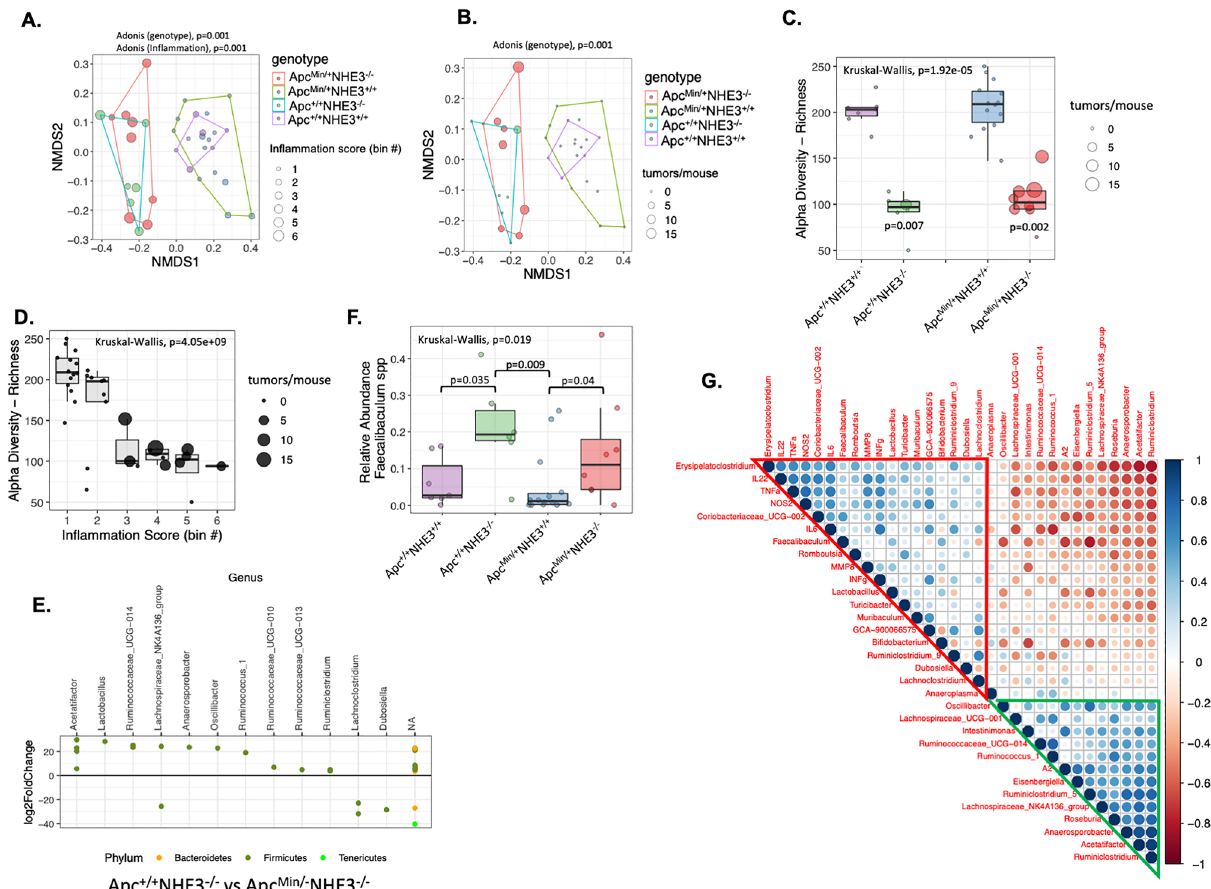
Figure 4. NHE3 deficiency leads to microbial dysbiosis and correlates with severity of inflammation and tumor number. Non-metric Multidimensional Scaling (NMDS) analysis based on Bray–Curtis distances ( A , B ), and richness (a-diversity measure; C , D ) were used to analyze the groups in the context of genotype, inflammation score, and tumor number. In all panels, dots represent samples from individual mice. The size of the dots corresponds to the inflammation score ( A ) or to the tumor multiplicity ( B – D ). Polygons connect points within the same cluster representing individual genotypes ( A , B ). In the bar plots ( C , D ) the lower and upper hinges represent the first and third quartiles respectively. The whiskers extend to the largest and lowest values. The middle line represents the median value. Permutational Multivariate Analysis of Variance Using Distance Matrices (Adonis test, A , B ) or Kruskal–Wallis H test followed by Wilcoxon rank sum test with continuity correction (panels C , D ) were used. Bonferroni p value adjustment method was used. ( E ) The impact of APC status on fecal microbial composition in NHE3 −/− mice was analyzed using DESeq2, differential abundance analysis tool. Each dot represents an individual ASV. The color of the dots represents a specific phylum (yellow— Bacteroidetes, dark green—Firmicutes, bright green Tenericutes). For this presentation, only significantly different taxa (Wald significance test < 0.05) with at least twofold change (absolute value of log2FoldChange > 1) were selected. ( F ). Relative abundance of Faecalibaculum spp. in fecal samples in all analyzed genotypes. Dots represent individual samples/mice, lower and upper hinges of the bars represent the first and third quartiles respectively. The whiskers extend to the largest and lowest values. The middle line represents the median value. Statistical differences were analyzed using Kruskal–Wallis H test followed by Wilcoxon rank sum test with continuity correction. ( G ) Heatmap of Spearman’s correlation between relative abundances of fecal microbial general (for the core gut genera, which summarized relative abundance across all samples for individual genus as higher than 50%). The circle size reflects the absolute value of corresponding correlation coefficient. Red and blue color represent positive and negative correlation respectively. Darker color represents stronger correlations. The green triangle highlights potentially beneficial bacteria negatively correlated with proinflammatory cytokines and potential pathobionts. The red triangle highlights genera positively correlated with inflammation indices. The heatmap was generated with corplot R package (ver 0.92; https:// github. com/ taiyun/ corrp